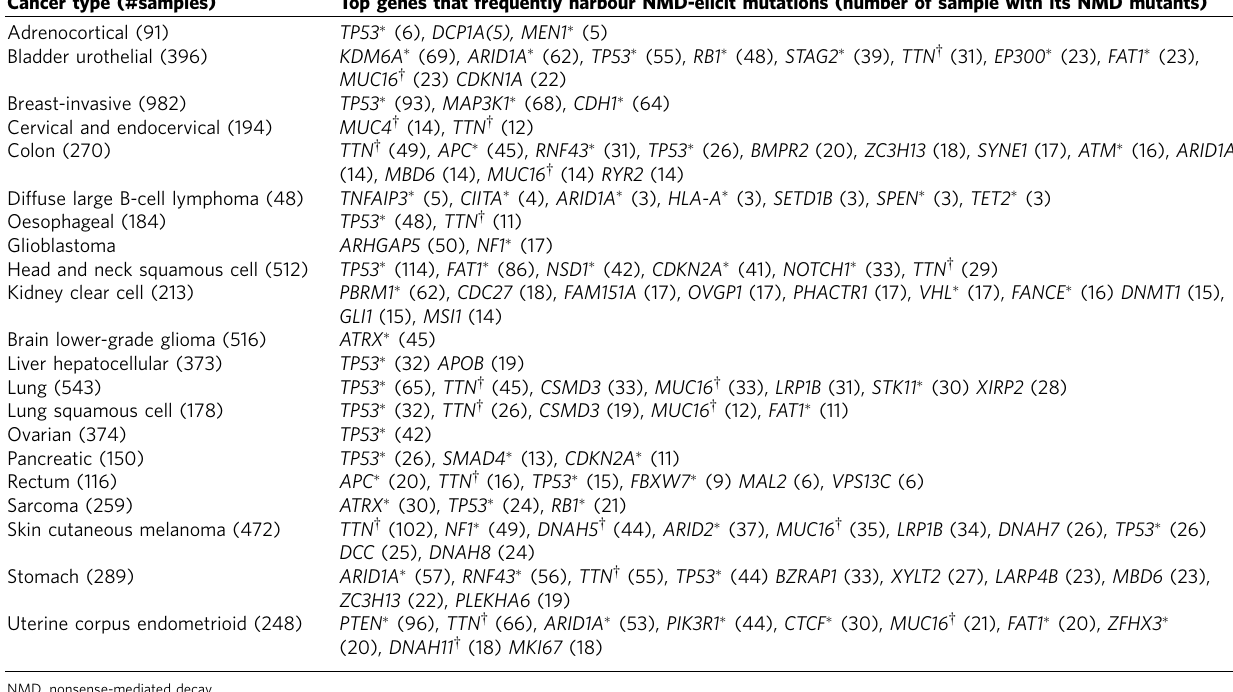
Table 1 | Top NMD-affected genes in 24 cancers. Cancer type (#samples) Top genes that frequently harbour NMD-elicit mutations (number of sample with its NMD mutants) Adrenocortical